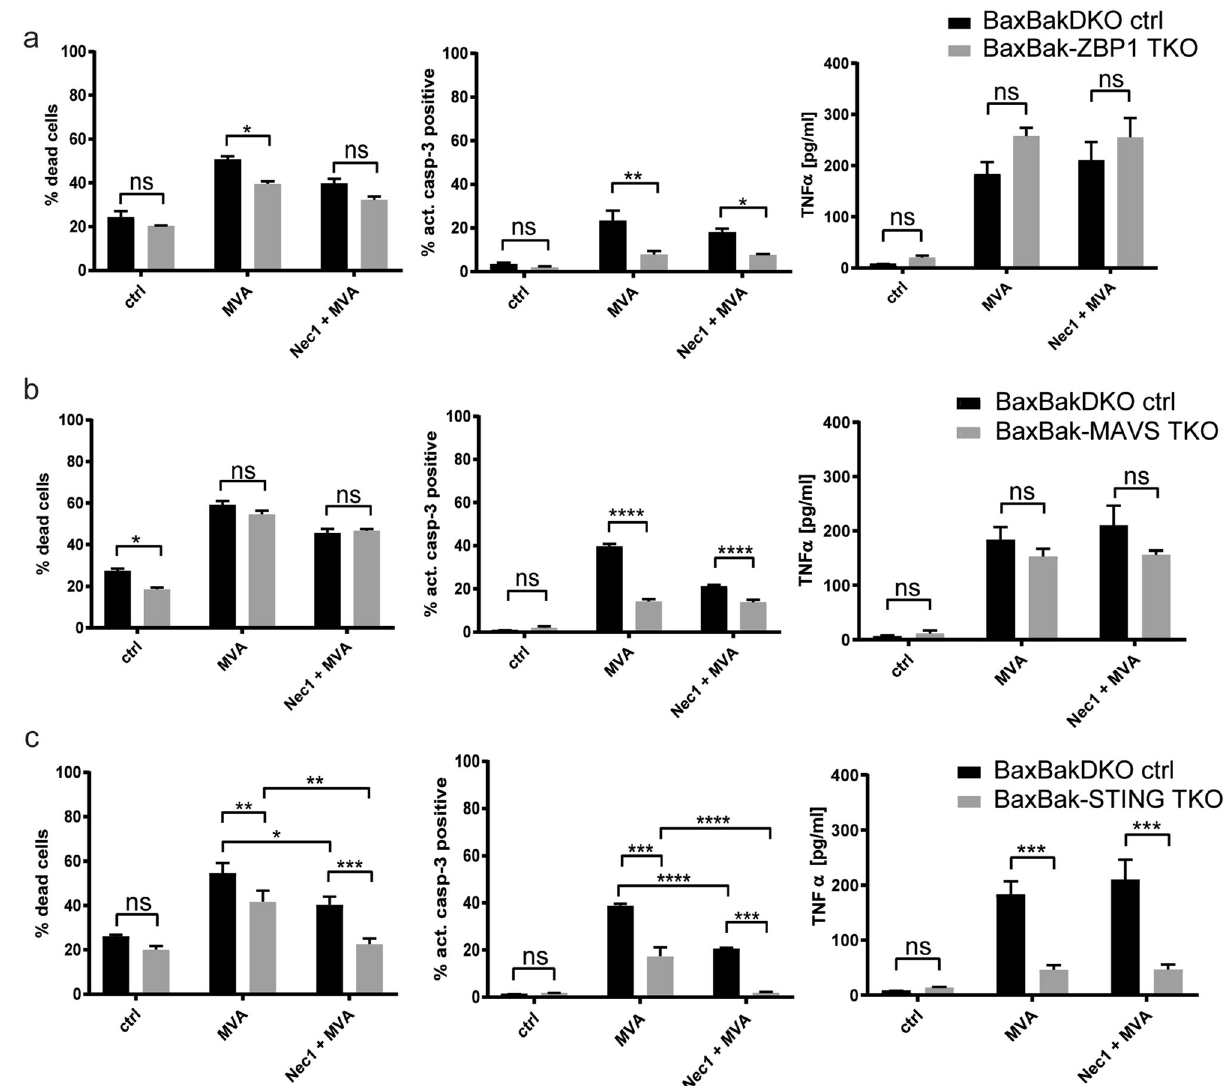
Fig. 6 Contribution of DNA recognition pathways to cell death-signaling in MVA-infected macrophages. a – c Bax/Bak-ZBP1 TKO ( a , gray bars), or Bax/Bak-MAVS TKO ( b , gray bars), or Bax/Bak-STING TKO cells (genetically modi fi ed by CRISPR/Cas) were infected with MVA at an MOI of 2 and cells and supernatants were harvested after 22 h. Cells were stained for annexin/PI (left panels) or active caspase-3 (middle panels) followed by fl ow cytometry analysis. Supernatants were analysed for TNF-secretion by a bead-based assay (right panels). Bax/Bak-DKO ctrl cells expressing an irrelevant gRNA directed against EGFP served as control (black bars). The inhibitor Nec-1 (10 µM) was added were indicated. Shown are the means/SEM of n = 3 independent experiments. * p < 0.05; ** p < 0.01, *** p < 0.001, **** p < 0.0001; ns nonsigni fi cant ( p ≥